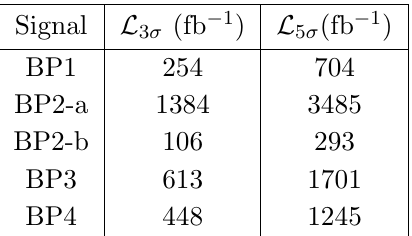
Table 8 . Required luminosities for discovery of mono lepton (cid:12)nal states with missing energy at p s = 13 TeV